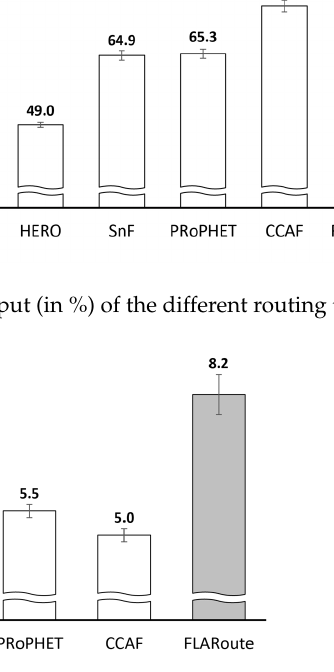
Figure 12. The average delivery delay (in h) of PRoPHET, and that of CCAF and FLARoute when incorporated into PRoPHET.